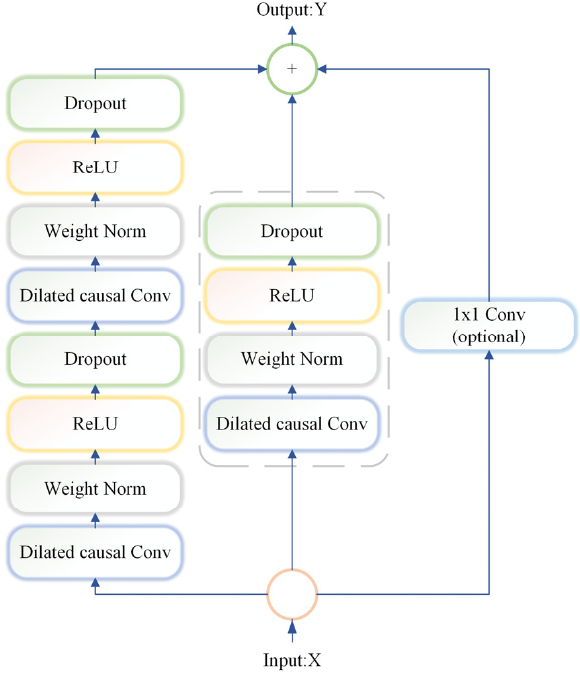
Figure 3. Residual block of